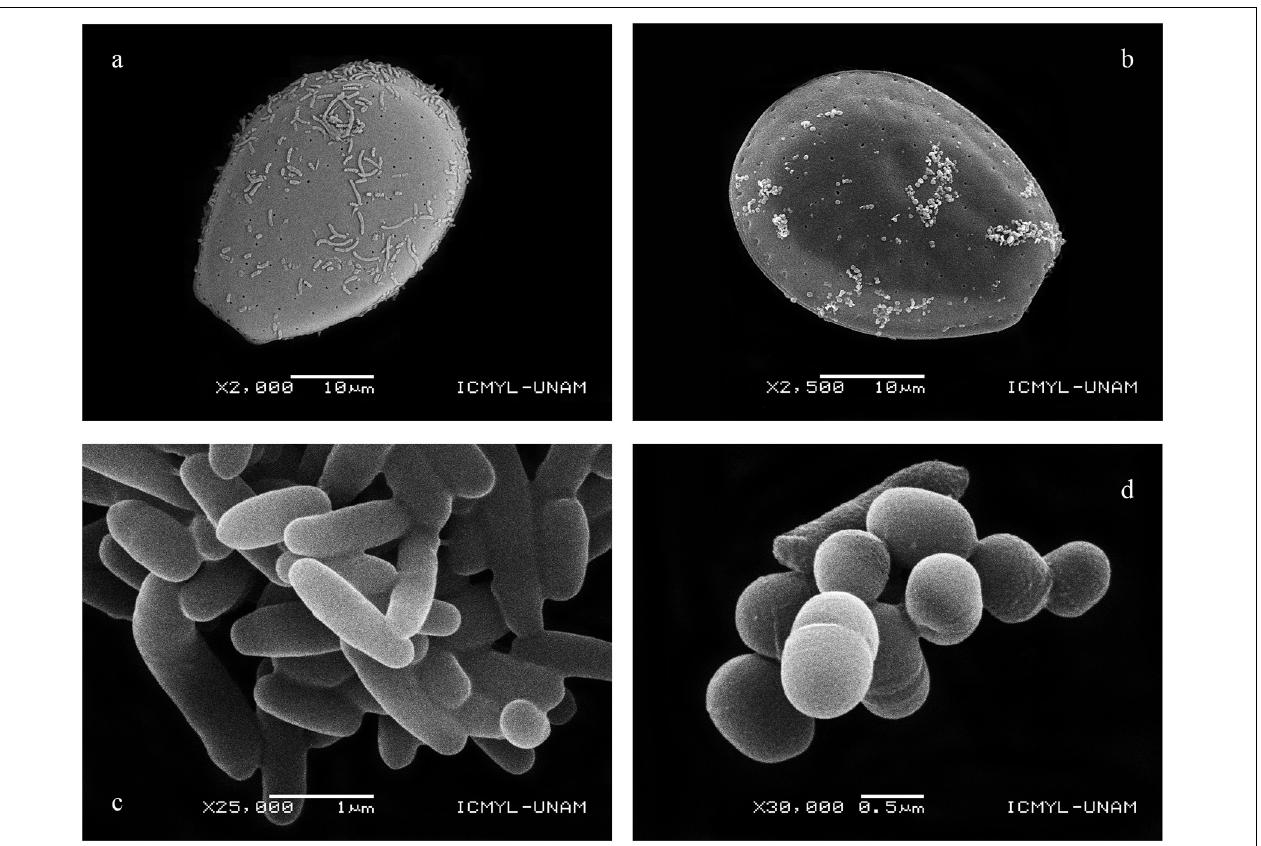
FIGURE 1 | Bacteria attached to Prorocentrum cells: (a) PA3; (b) PA19, and isolated from cell aggregates versus culture medium: (c) Thalassospira sp. isolated exclusively from cells belonging to PA11; (d) Kocuria sp. isolated exclusively from the culture medium of PA11, PA12, and